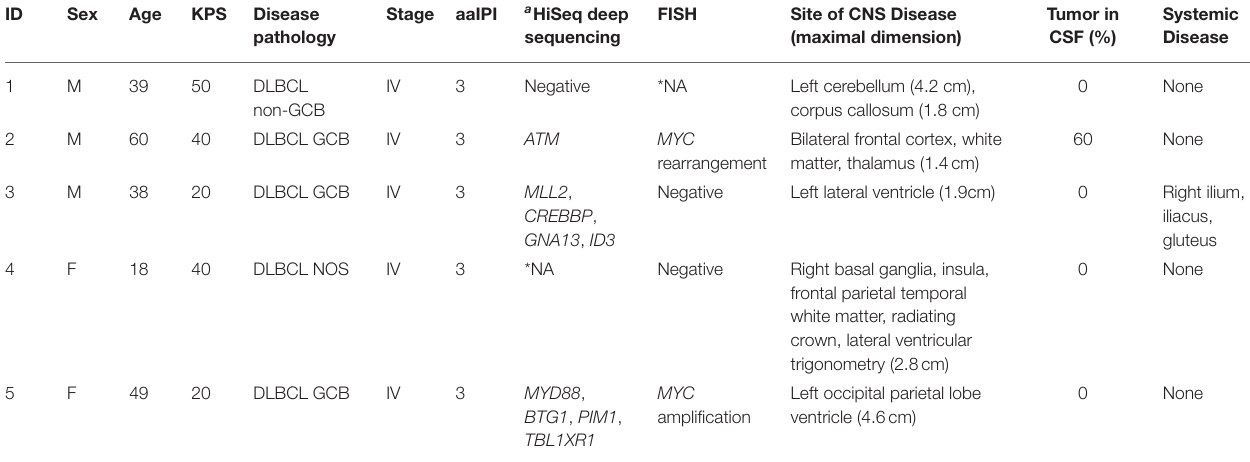
TABLE 1 | Clinical characteristics of patients during the time of CAR-T cells